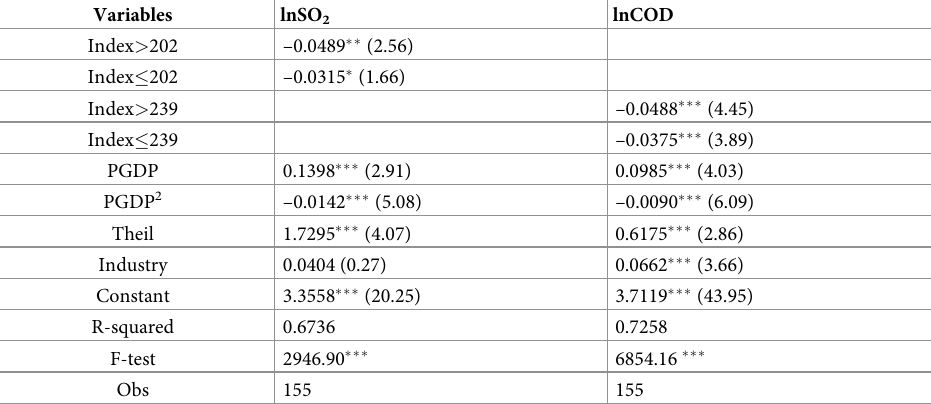
Table 7. Regression results of threshold